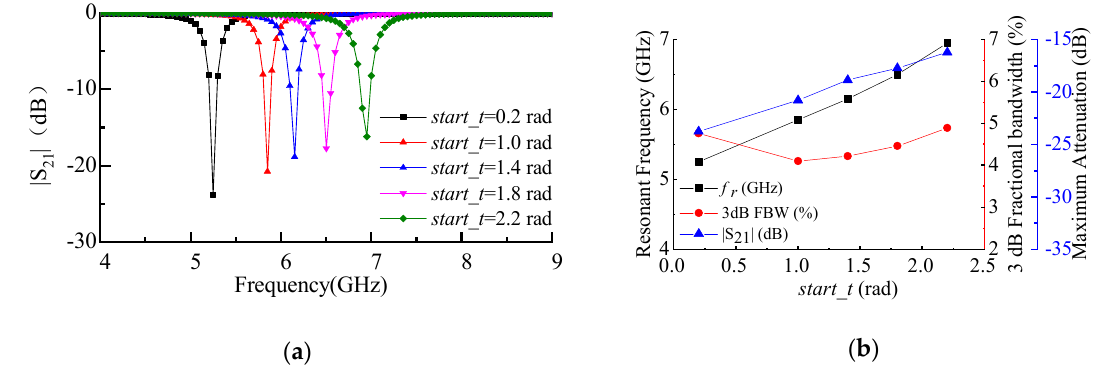
Figure 7. ( a ) Simulation results with different start_t by using HFSS. ( b ) Resonant frequency, maximum attenuation, and 3 dB Fractional Bandwidth with different start_t.